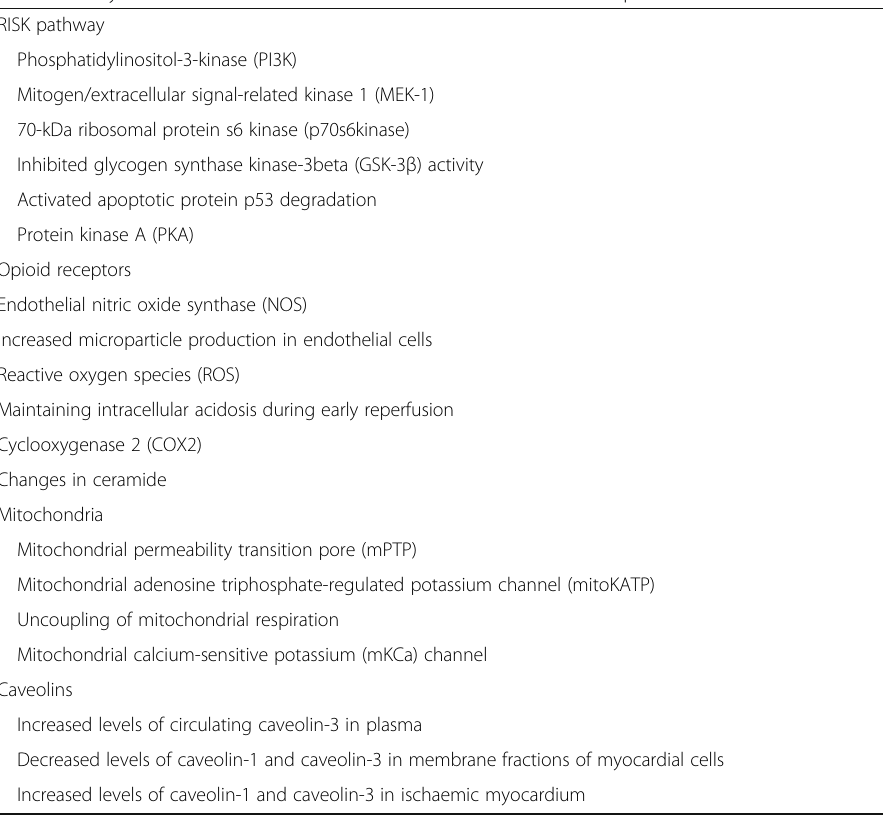
Table 1 Enzymes and mediators involved in helium mediated cardioprotection RISK pathway Phosphatidylinositol-3-kinase